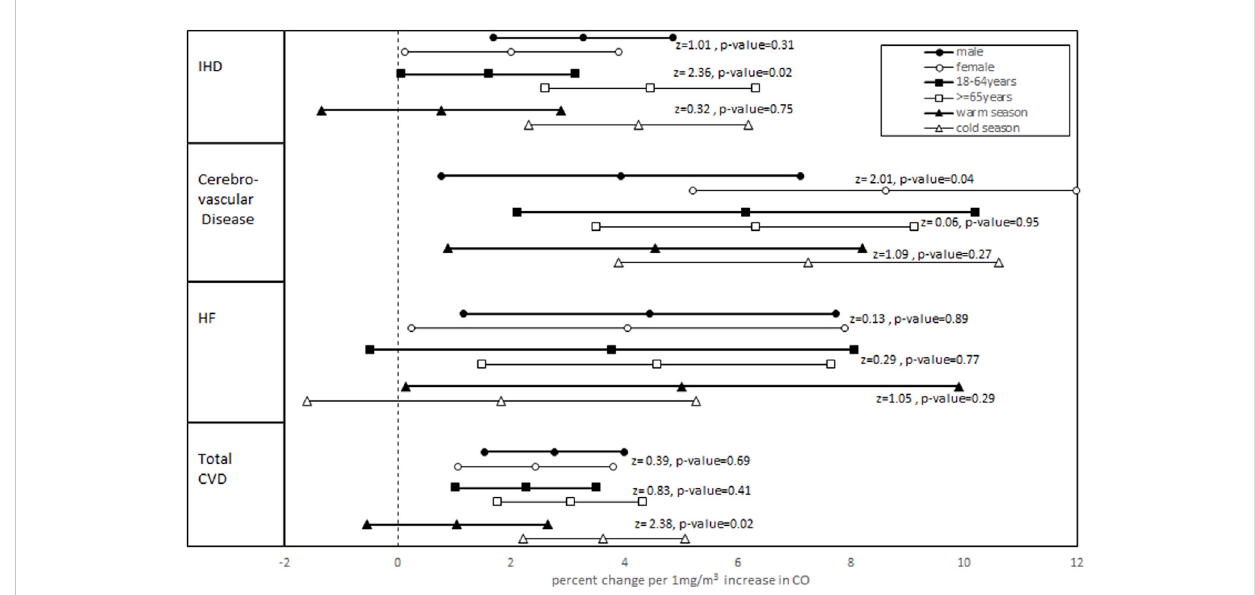
FIGURE 1 Adjusted percent change and 95% con fi dence interval in daily hospital admissions for total and cause-speci fi c CVDs per 1 mg/m 3 CO increase strati fi ed by age groups, sex, and seasons. (Z-statistics and relevant p-values for comparing subgroups are